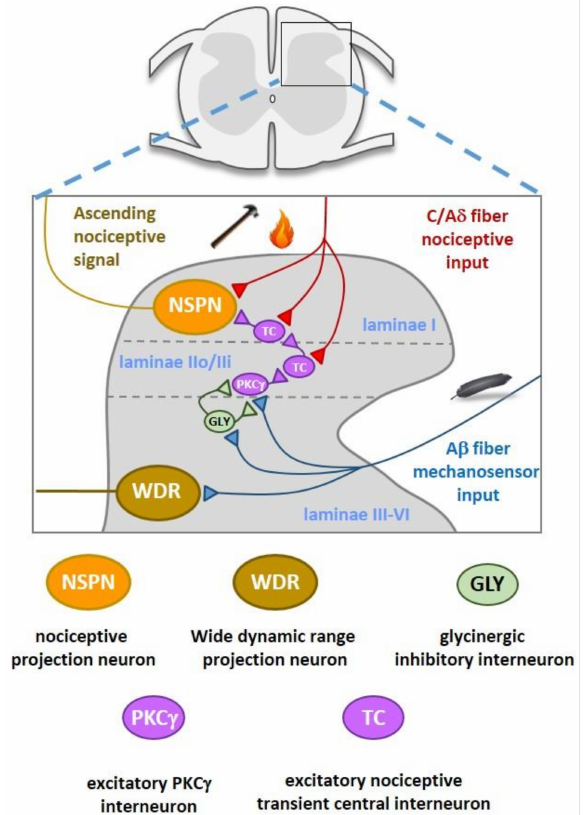
Figure 1. Glycinergic interneurons within the deep dorsal horn (laminae III) are part of a feed-forward inhibitory circuit that prevents innocuous A β fiber input from driving nociceptive pathways. Loss of segmental glycinergic inhibitory control via application of strychnine, nerve injury, or targeted ablation and silencing allows low threshold A β mechanosensor input to drive NS secondary order projection neurons, resulting in